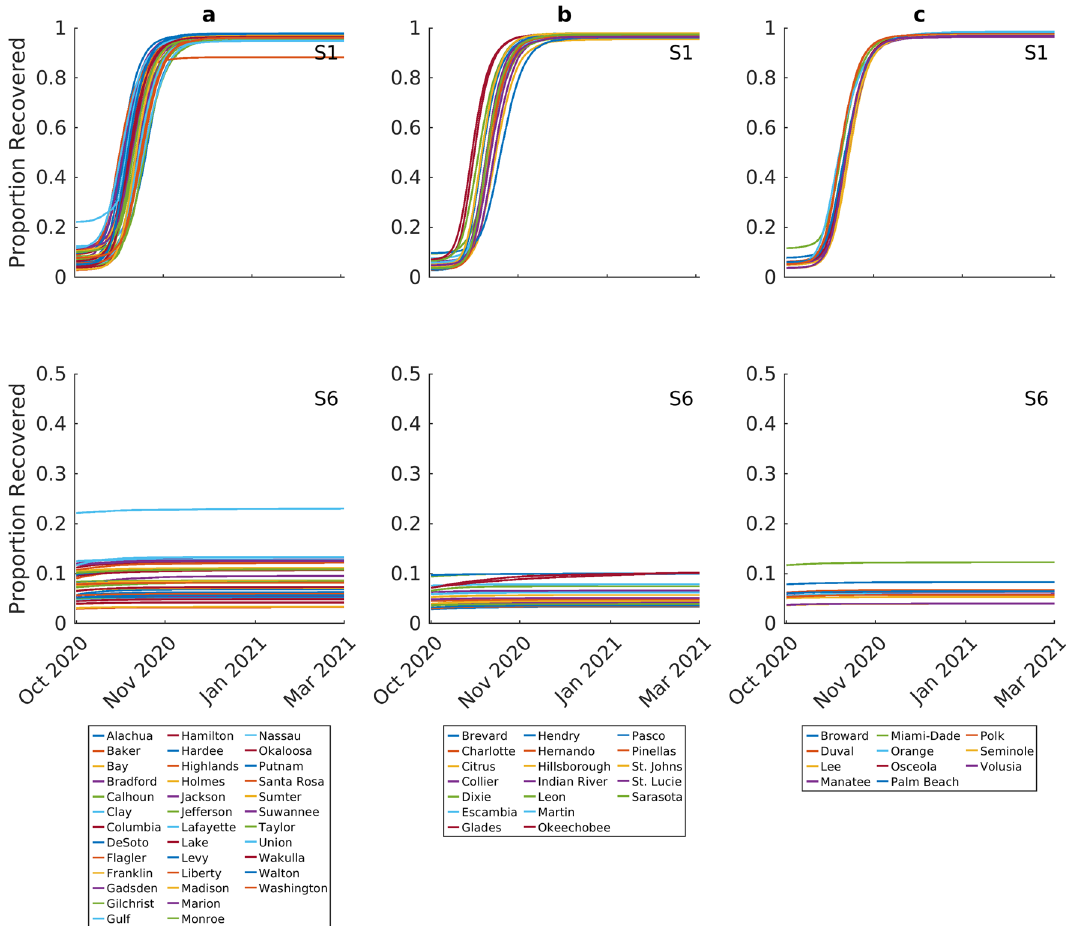
Figure 6. Proportion recovereds predicted over time for Scenario 1 (full release of interventions on October 1st) and Scenario 6 (lockdown, social distancing, and quarantining through to March 2021). Each curve represents the median prediction for a given county. The results are stratified by initial incidence growth rate in each county (Group a < 0.05, Group b > 0.05–0.15, Group c >